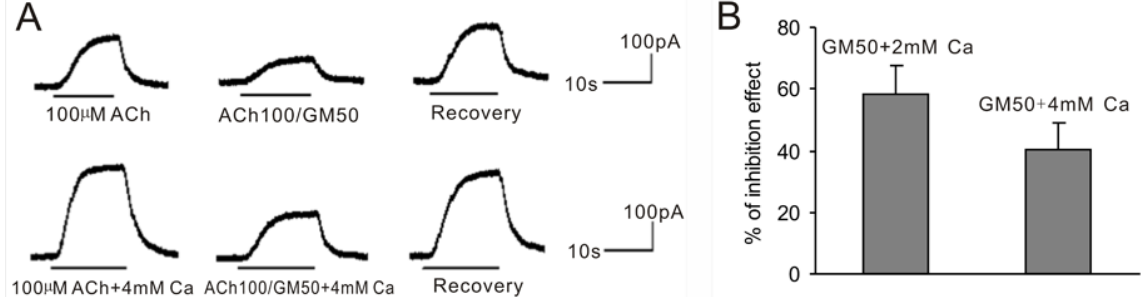
antagonizes the GM inhibition effect of the BK current. ( A ) The Figure 5. Increasing [Ca 2+ ] o sequential current traces evoked by 100 µM ACh alone or with 50 µM GM (ACh100/GM50) in the standard ([Ca 2+ ] = 2 mM) or 4 mM [Ca 2+ ] extracellular solution. The above currents o o were obtained from the same VHC II at −50 mV; ( B ) Bar histogram shows the percentage of inhibition effect of 50 μM GM on the BK current evoked by 100 μM ACh in standard extracellular solution or 4 mM [Ca 2+ ] solution. Each point is the mean ± SD of 6 cells. o